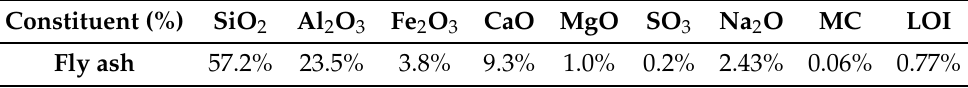
Table 1. Fly ash chemical composition (test results obtained from materials supplier).